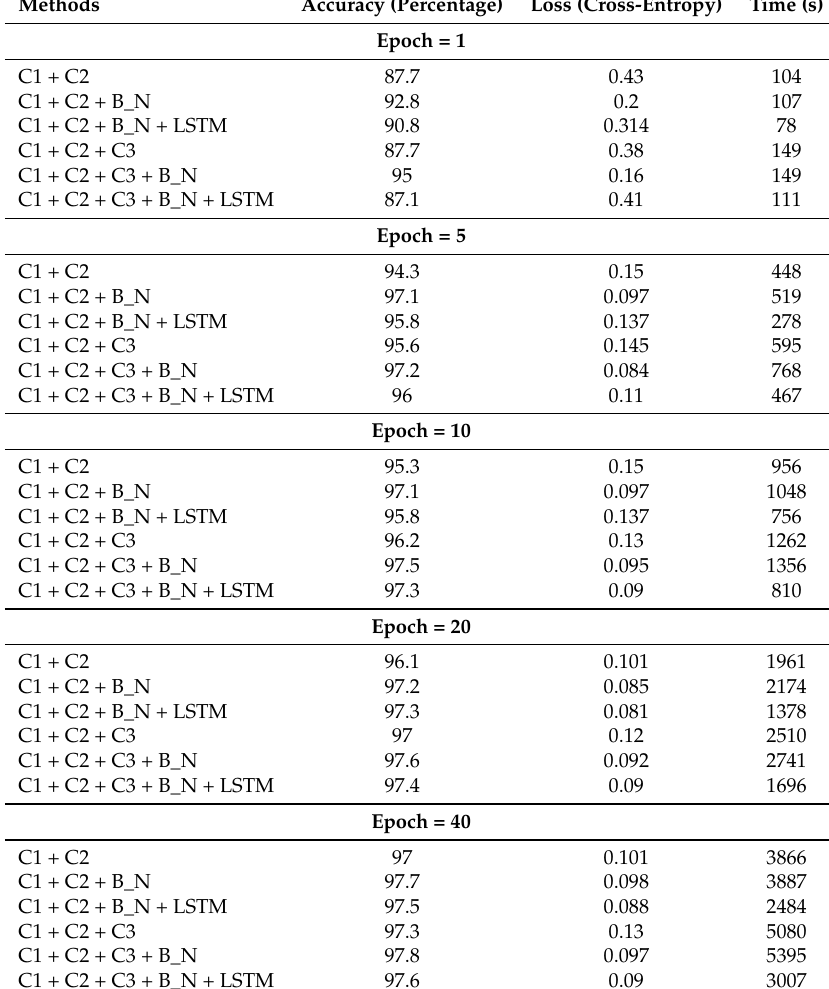
Table 4. Accuracy, loss and time for different numbers of epochs (10% sample) for the MNIST